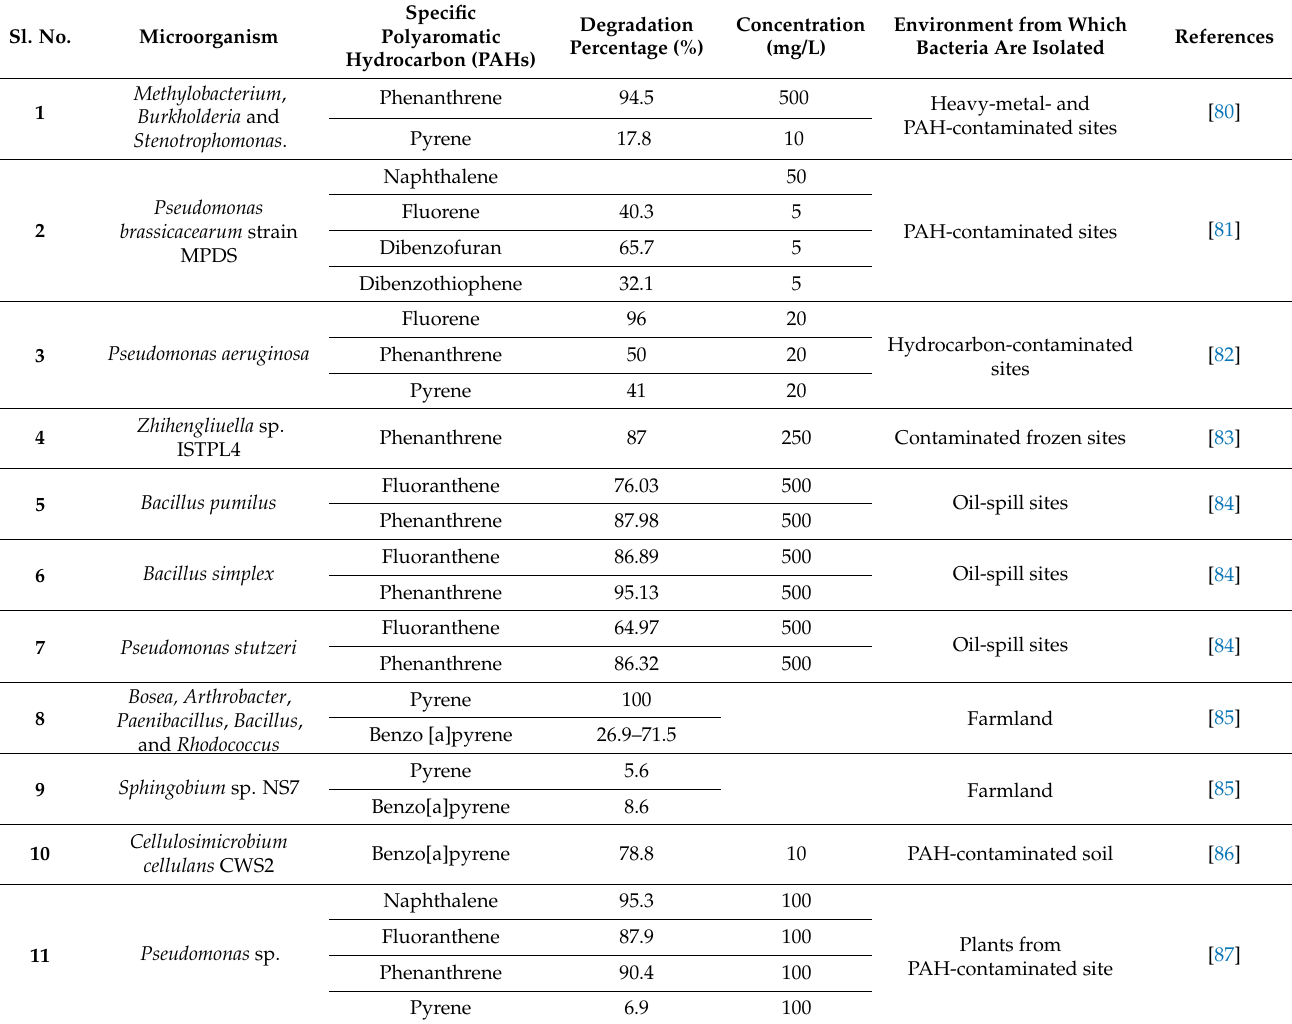
Table 1. Degradation of PAHs by various microorganisms in soil environment (with their concentra- tions and degradation